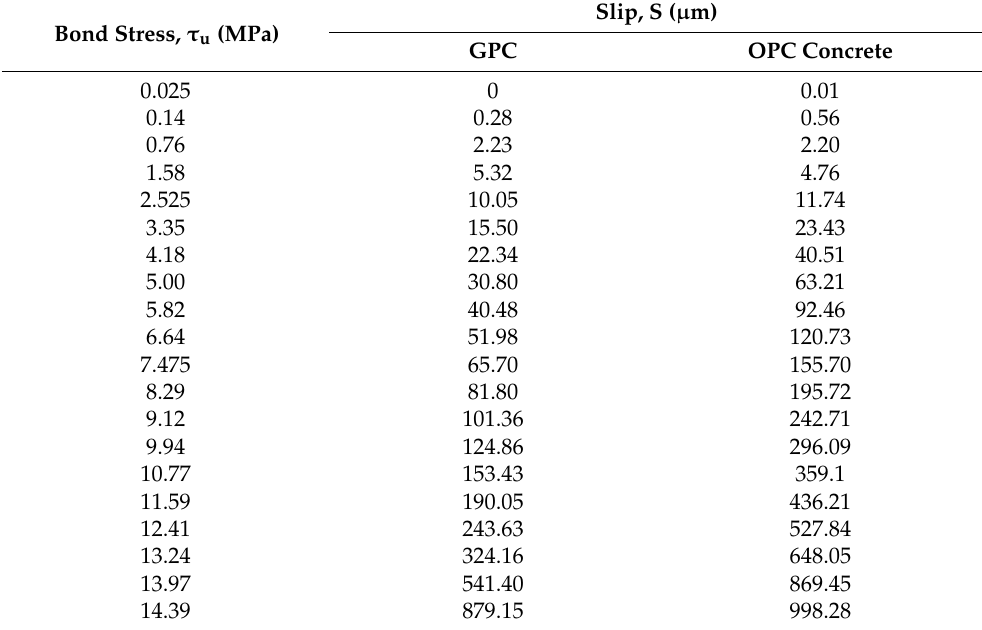
Table 5. The slip values and corresponding bond